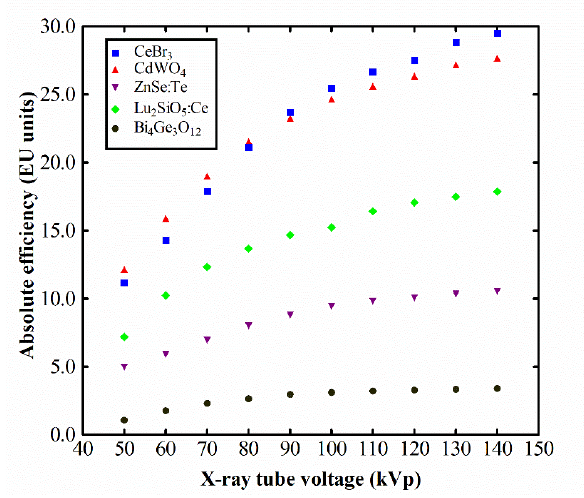
Figure 2. Absolute efficiency versus X-ray tube high voltage.